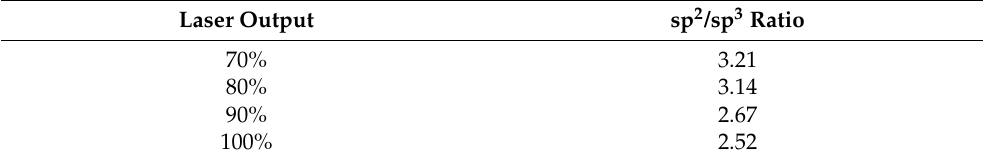
Table 2. sp 2 /sp 3 ratio of carbon-doped SUS304 by laser output.